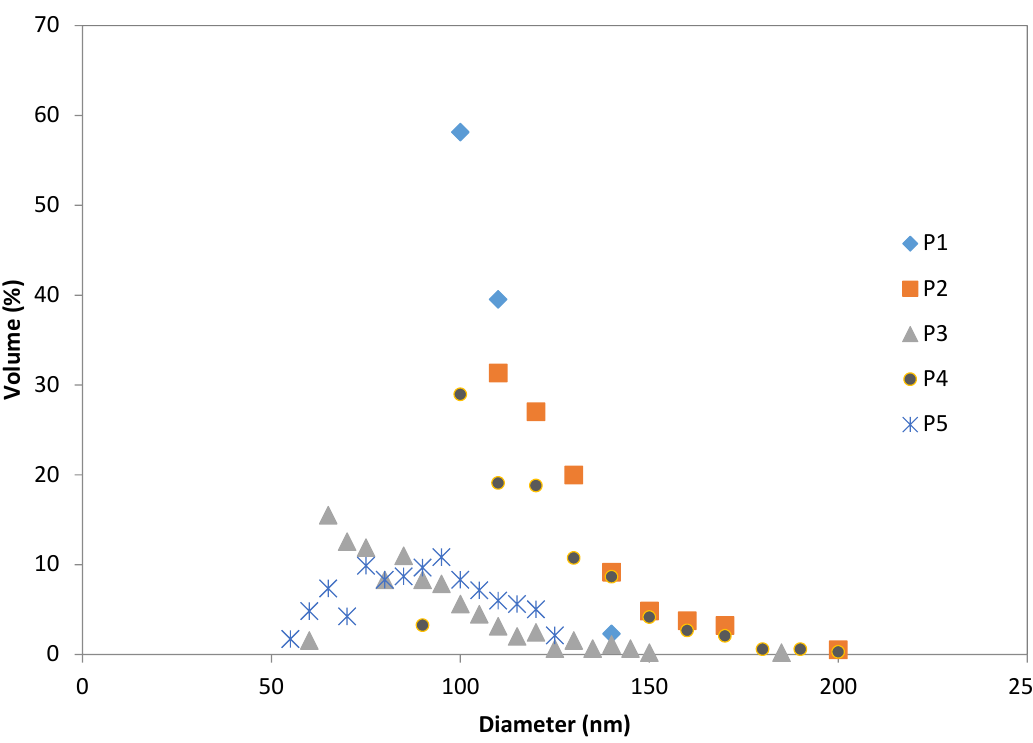
Figure 5. Pore size distribution of the bottom surface of PPSU-PES membranes.